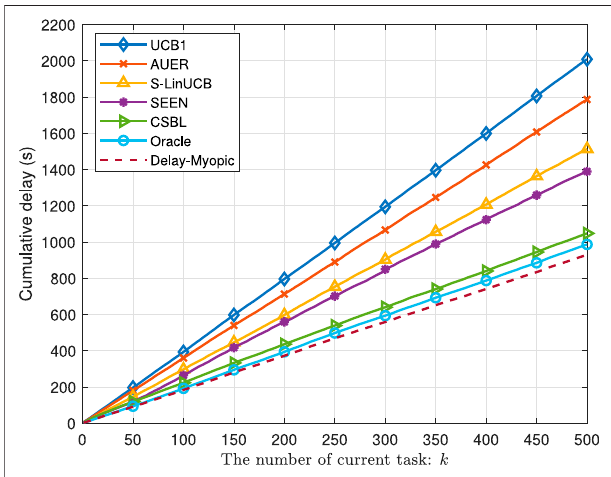
FIGURE 3 | Performance comparison in terms of the cumulative